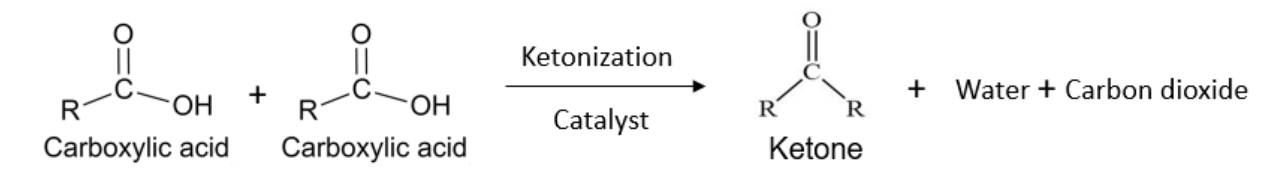
Figure 3. Ketonization of carboxylic acids. Simple reaction chemistry.